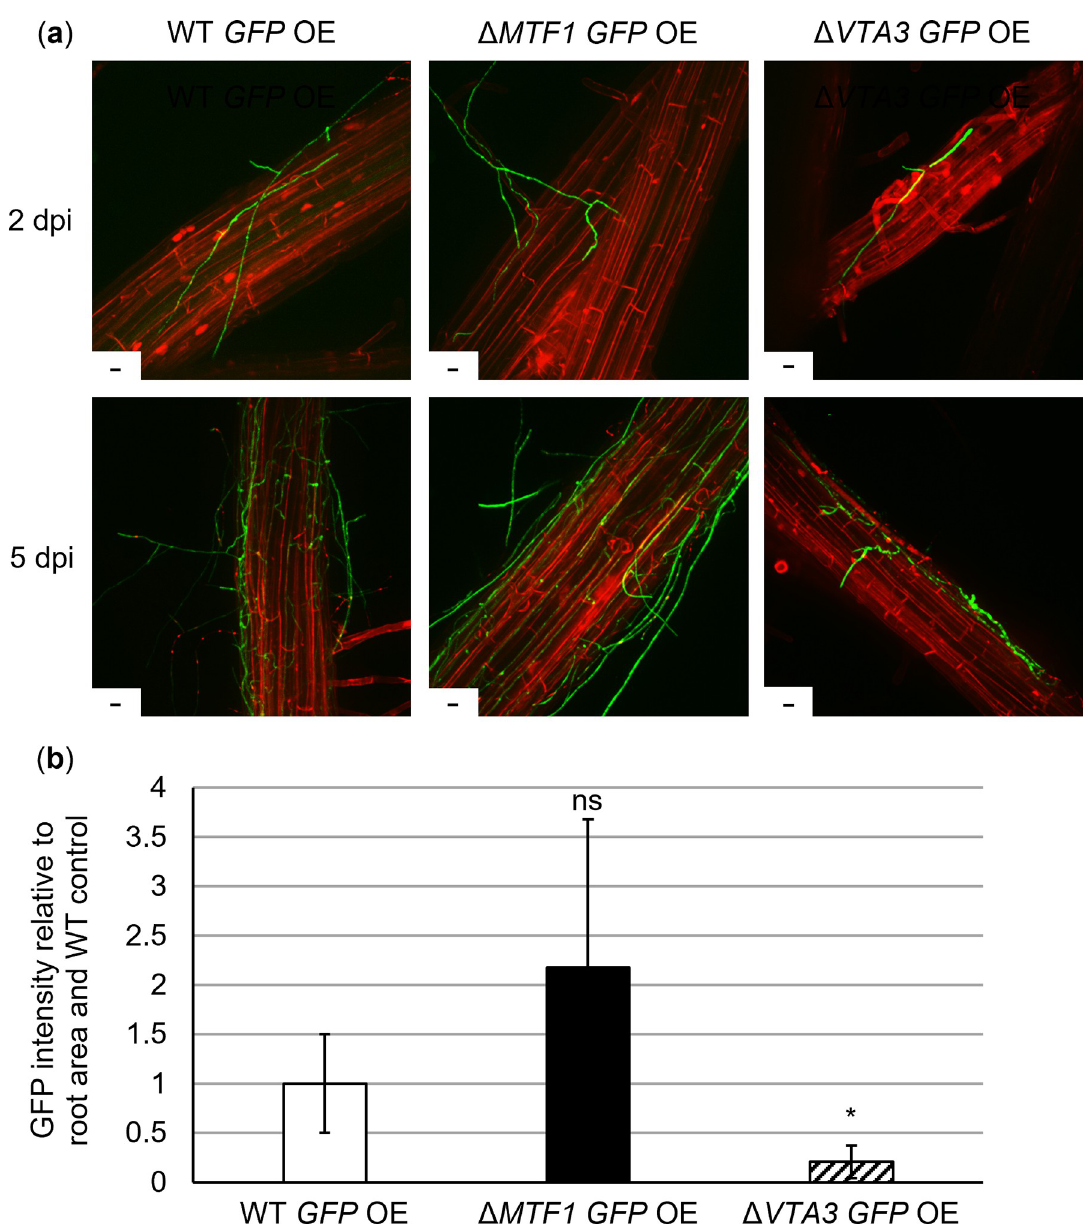
Fig 6. MTF1 is dispensable for Arabidopsis thaliana root colonization by Verticillium dahliae . A . thaliana seedlings (three-week- old) were treated by root-dipping with spores of V . dahliae JR2 wild-type (WT GFP OE), Δ MTF1 ( Δ MTF1 GFP OE) or Δ VTA3 ( Δ VTA3 GFP OE) strains constitutively expressing (OE) ectopically integrated GFP . Fungal colonization of the roots was observed at two and five days post inoculation (dpi). Root cells were stained with 0.05% propidium iodide/0.01% silwet solution. Two independent experiments were performed. (a) Representative fluorescence micrographs depict similar initial (2 dpi) and complete root colonization (5 dpi) by V . dahliae wild-type or MTF1 deletion strains compared with the Δ VTA3 control, which did not propagate to the same extent on the root surface (scale = 10 μ m). (b) Quantification of fungal root colonization was performed at 5 dpi. For each root, 10 to 15 images were taken at randomly selected sections. Roots of two plants per treatment were considered as one biological replicate. The green fluorescence of GFP -expressing fungal hyphae was quantified relative to the root area. Shown are the means of four biological replicates ± SD. A t -test was used for statistical analysis. No significant difference was detected between plant roots colonized by the wild-type or the MTF1 deletion strain (ns, not significant), in contrast to the Δ VTA3 control strain, which is impaired in its ability to colonize plant roots ( � , P < 0.05).